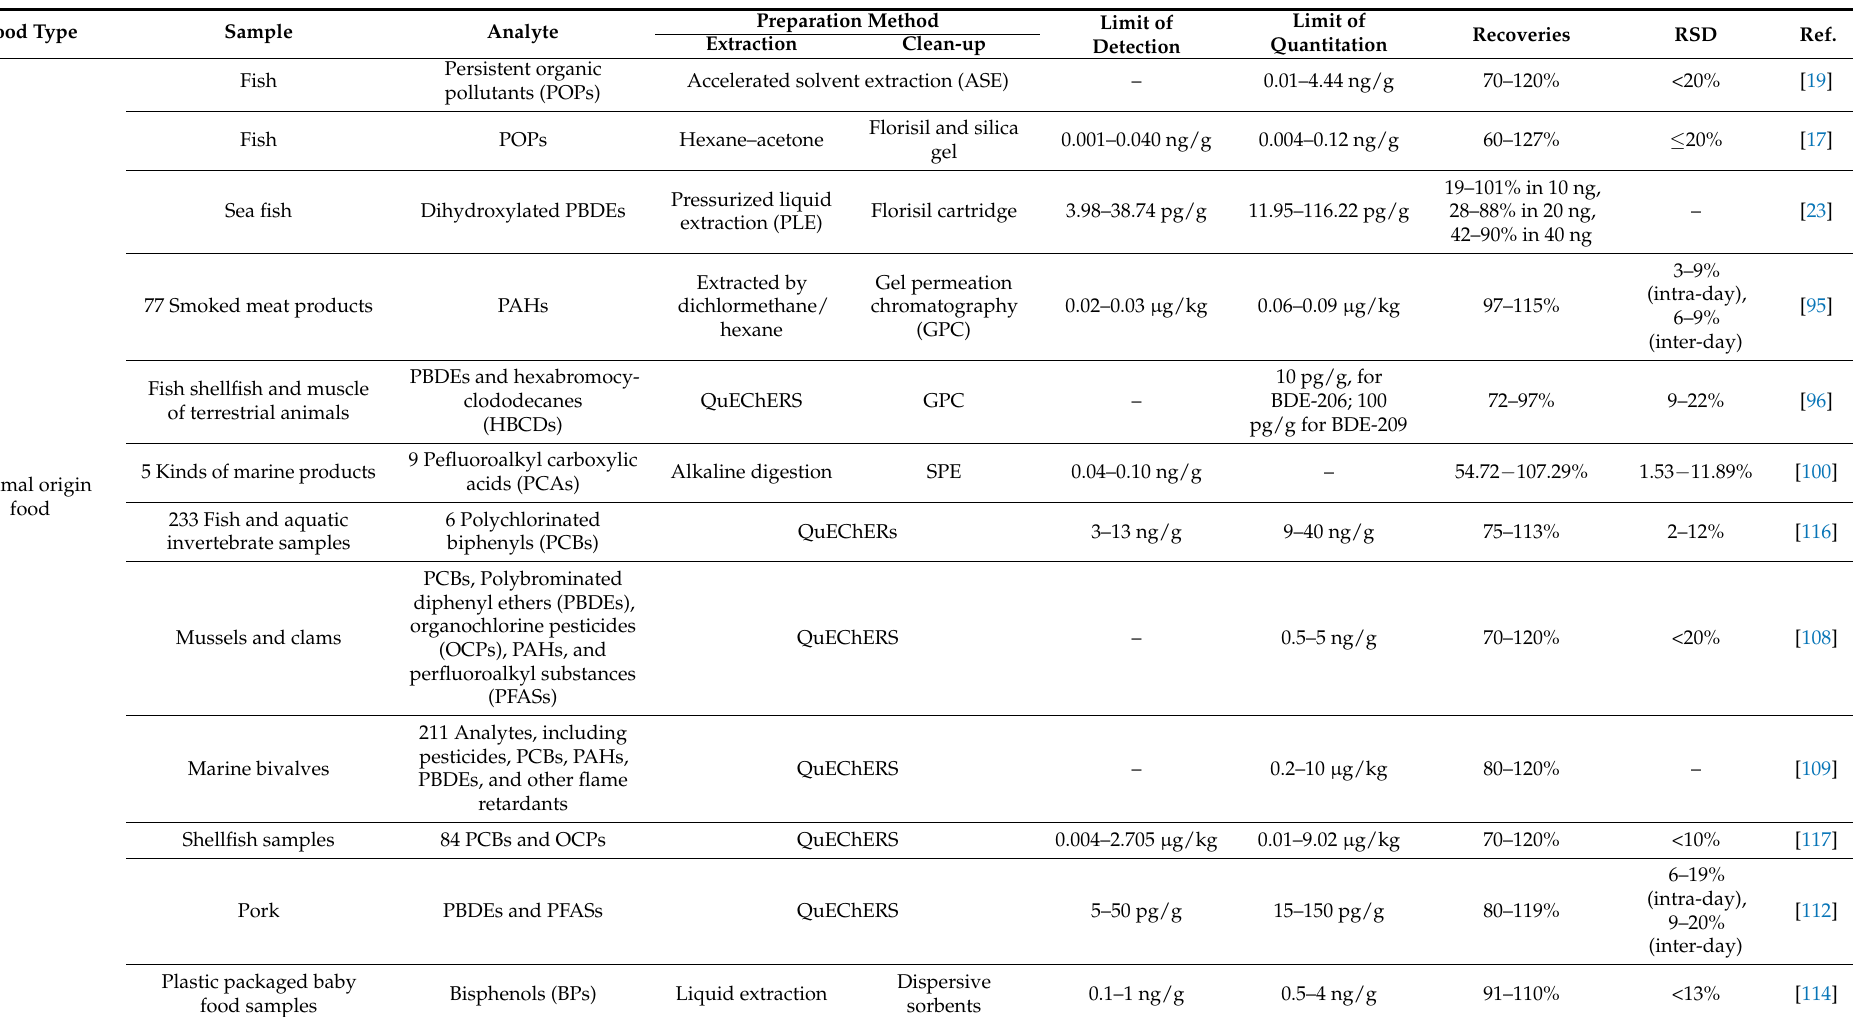
Table 3. Application of preparation methods for emerging risks analysis in food by GC–MS/MS during the past three